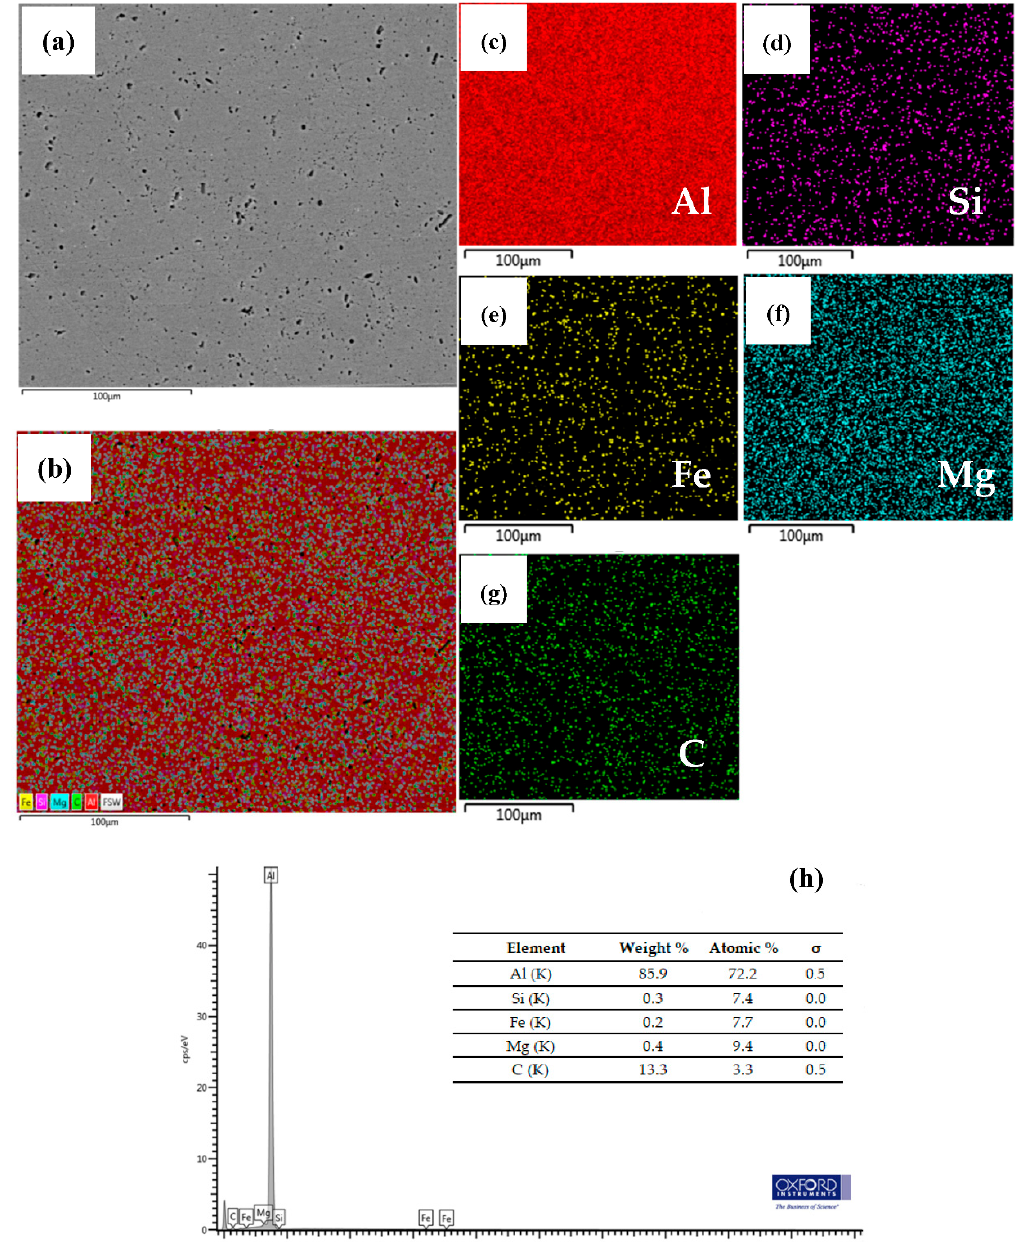
Figure 11. The micrographic mapping image by EDX spectroscopy of the welded joint: ( a ) the presence of SEM micrographs, ( b ) the presence of element phase maps, ( c ) the presence of aluminum element, ( d ) the presence of silicon element, ( e ) the presence of iron element, ( f ) the presence of manganese element, ( g ) the presence of carbon element, and ( h ) the present of EDX results of the secondary phase.